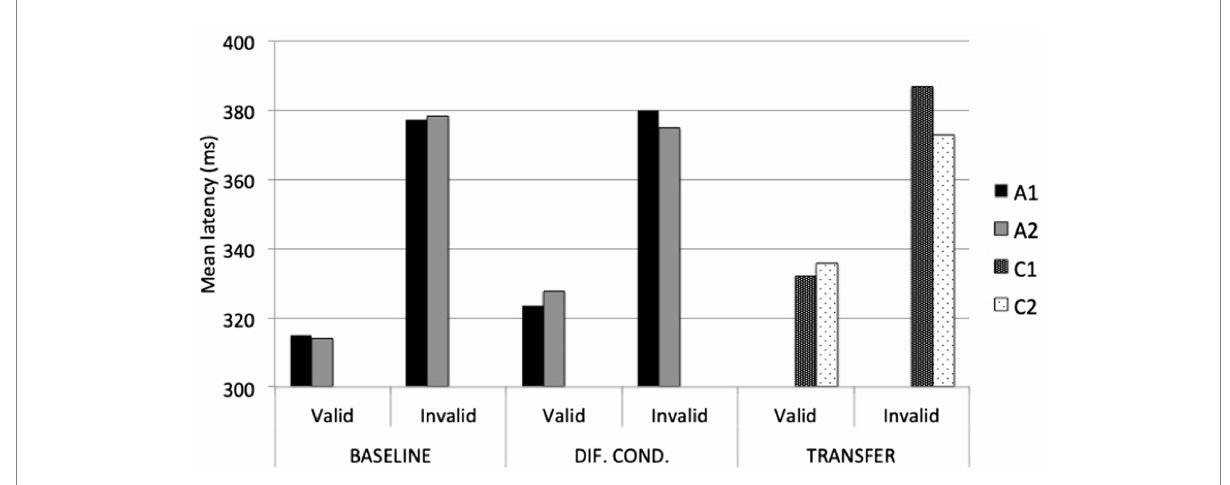
FIGURE 4 Average response latencies to A1 (CS+), A2 (CS − ), C1, and C2, during Baseline, Differential Fear Conditioning, and Transfer Test